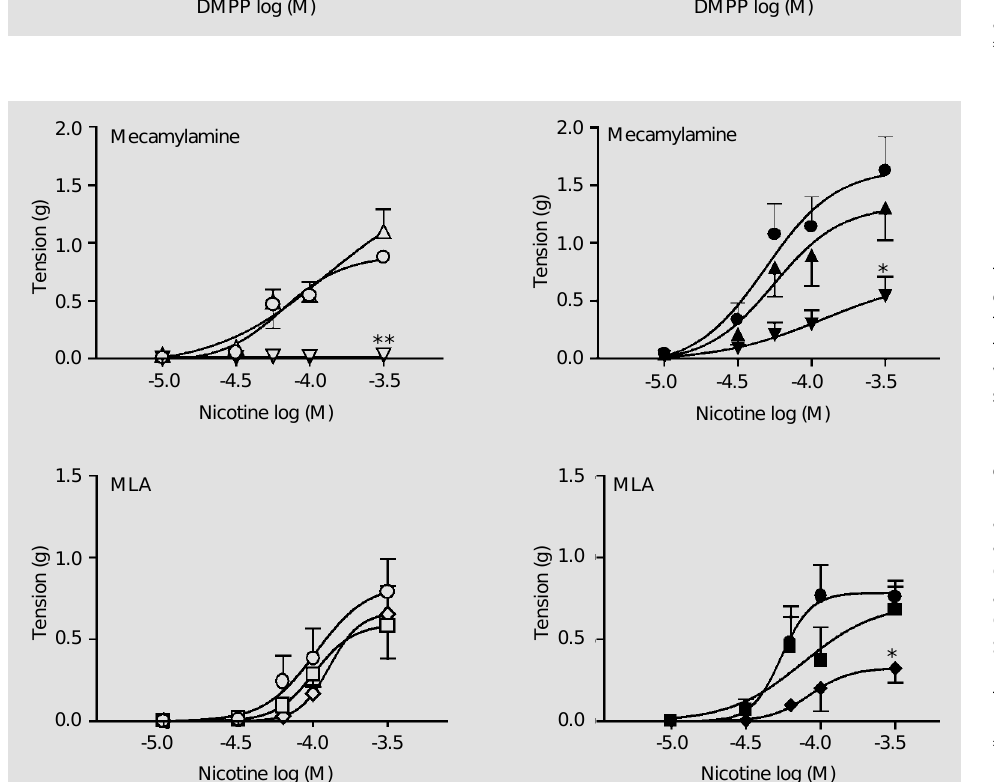
Figure 2 - Mecamylamine inhibi- tion of the noncumulative con- centration-effect curve for di- methylphenylpiperazinium (DMPP) in the prostatic portion of the rat vas deferens. Animals were killed at 15:00 h (open symbols) or 21:00 h (closed sym- bols). Control in the absence of mecamylamine (squares, N = 5), 1 nM mecamylamine (triangles, N = 4), 10 nM mecamylamine (inverted triangles, N = 5). Data are reported as mean ± SEM. *P<0.01 compared to control (ANOVA + Newman Keuls test).